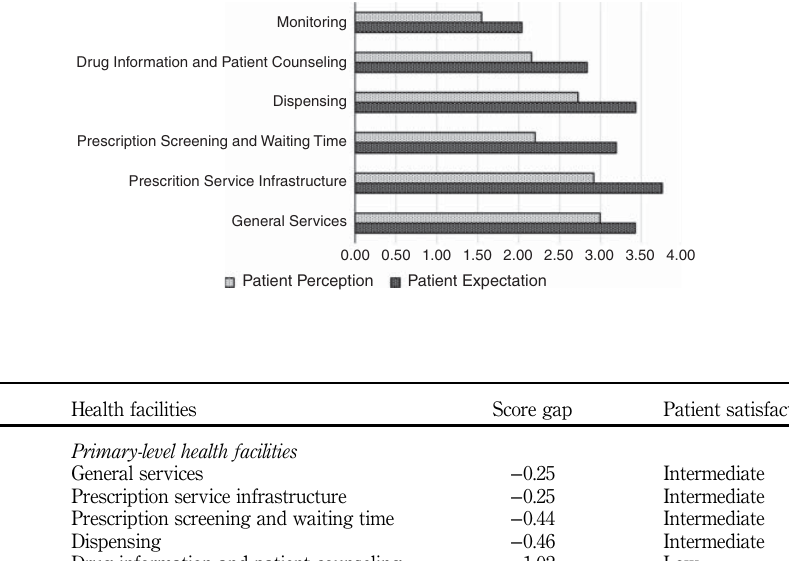
Table IV. Patient